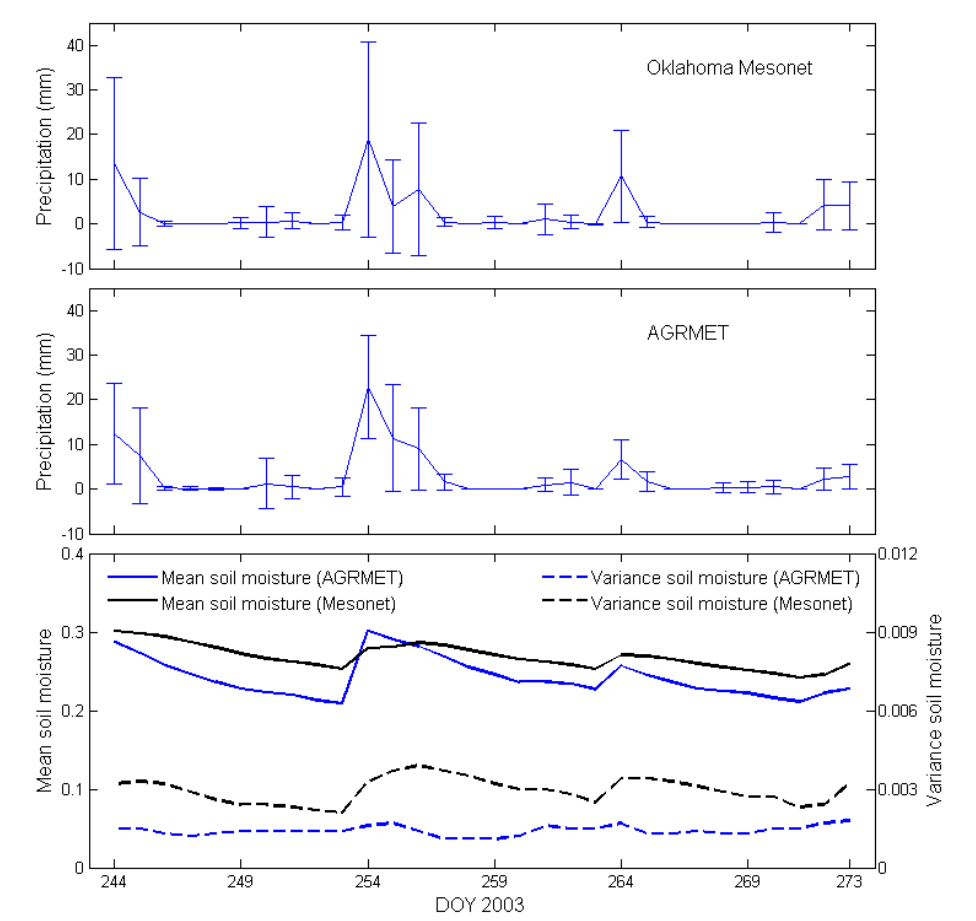
Figure 5. Mean and standard deviation of precipitation (a) observed by Oklahoma Mesonet, (b) AGRMET precipitation (c) soil moisture measured at Oklahoma Mesonet sites and derived from AGRMET